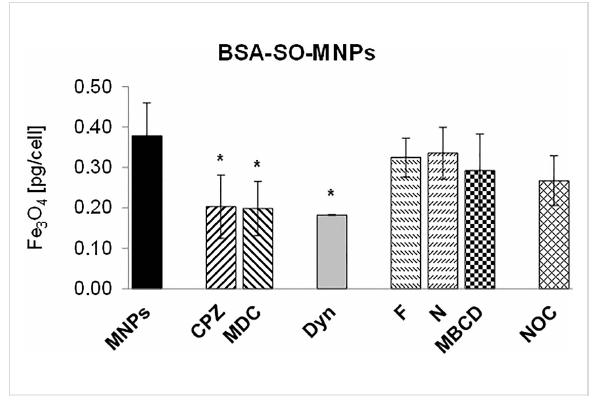
Figure 1: The effect of endocytic inhibitors on the internalization of BSA-SO-MNPs. MNPs – BSA-SO-MNPs (2 mM), CPZ – chlorpro- mazine (25 µM), MDC – monodansylcadaverine (150 µM), Dyn – dyna- sore (80 µM), F – filipin (5 µM), N – nystatin (20 µM), MBCD – methyl- β -cyclodextrin (100 uM), NOC – nocodazole (25 µM). Data are given as mean values ± SD from at least three independent experiments carried out twice.